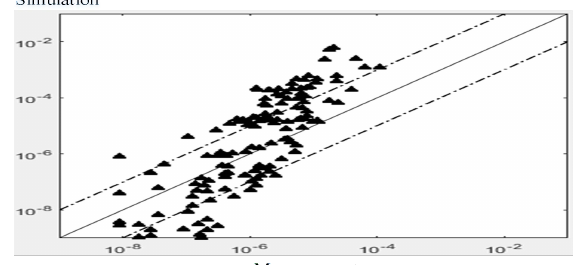
Figure10. Scatter diagram of atmospheric dispersion